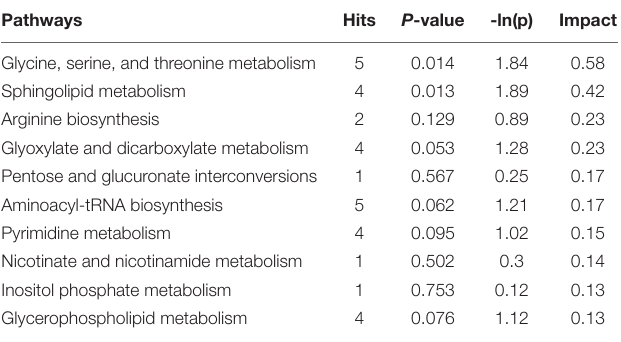
TABLE 3 | Metabolic pathways related to differential metabolites between PE and non-PE neonates. Pathways